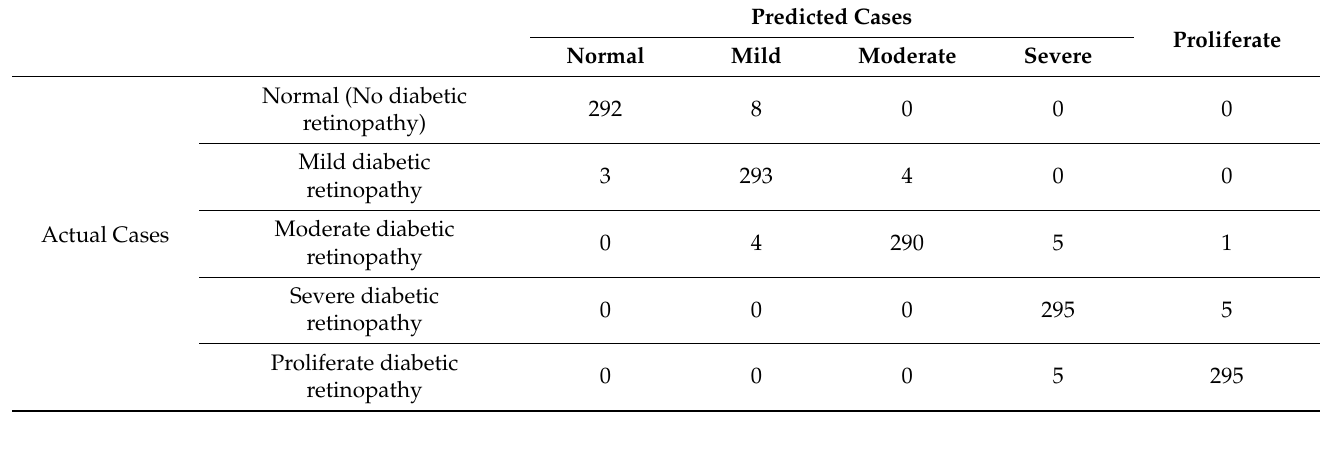
Table 9. Confusion matrix for the R-CNN.